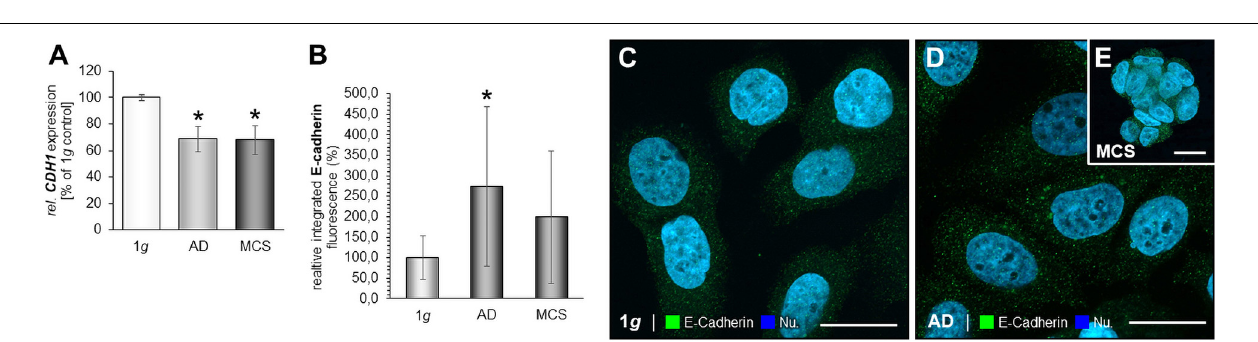
FIGURE 5 | Focal adhesions in MCF-7 BCC. The PTK2 mRNA expression (A) , PXN mRNA expression (B) of MCF-7 cells exposed to the RPM. In addition, the gene expression of TLN1 (C) and analysis of the fluorescence intensity of talin (D) , IFS of 1 g control cells (E) and RPM-exposed MCF-7 BCC [AD: (F), MCS: (G) ] is given. VCL mRNA (H) and analysis of the fluorescence intensity of vinculin (I) , the IFS of vinculin are shown in 1 g control cells (J) and RPM-exposed cells [AD: (K), MCS: (L) ]. * p < 0.05 1 g vs. AD and/or MCS and # p < 0.05 AD vs. MCS.